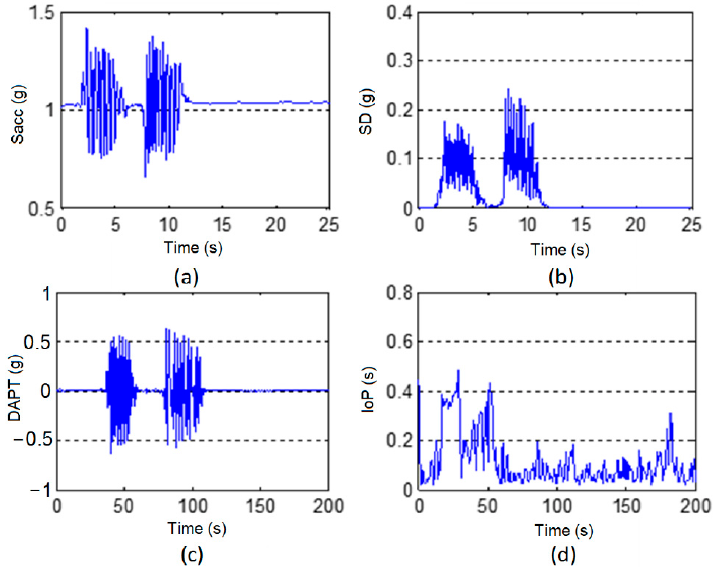
Figure 11. Diagram of features in D06: ( a ) Sacc over time; ( b ) SD over time; ( c ) DAPT over time; ( d ) IoP over time.